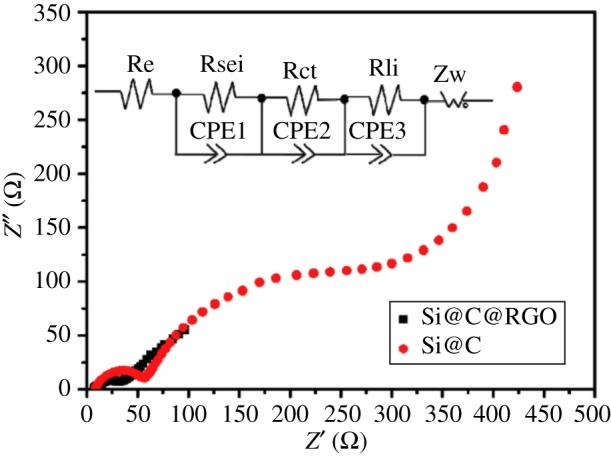
Nyquist plots of the Si@C@RGO and Si@C composite anodes [88].